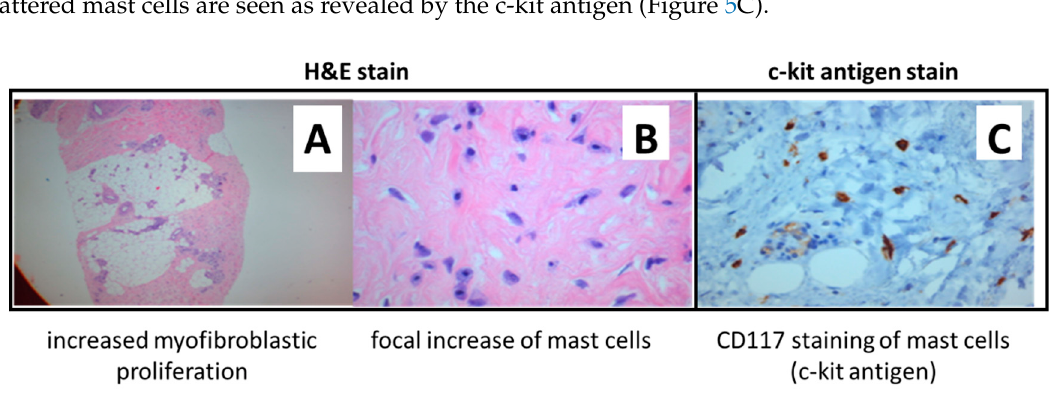
Figure 5. ( A – C ) Immunohistochemical analysis of tissue biopsies from Patient 2, showing increased myofibroblastic activity, with a relative focal increase of mast cells (H&E stain 5A and 5B, respectively), and c-kit (CD117) antigen stain showing reduced CD117+ mast cells over WMCS treatment (5C).